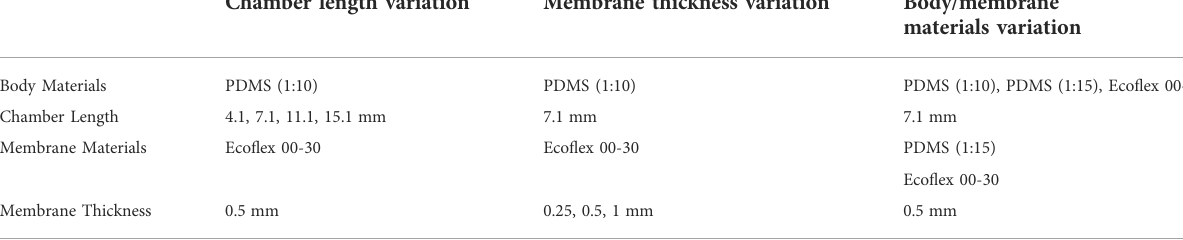
TABLE 2 Balloon actuator design for each experimental